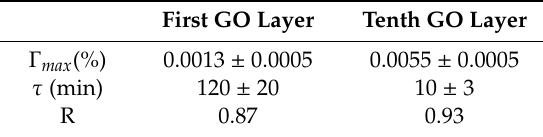
Table 1. Fitting parameters of GO adsorption kinetics. R is the correlation coe ffi